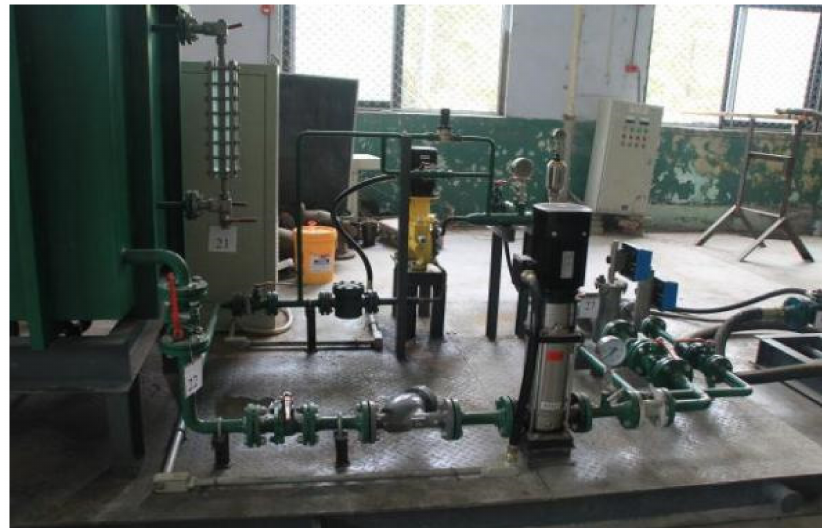
Figure 4. Atomization generator.